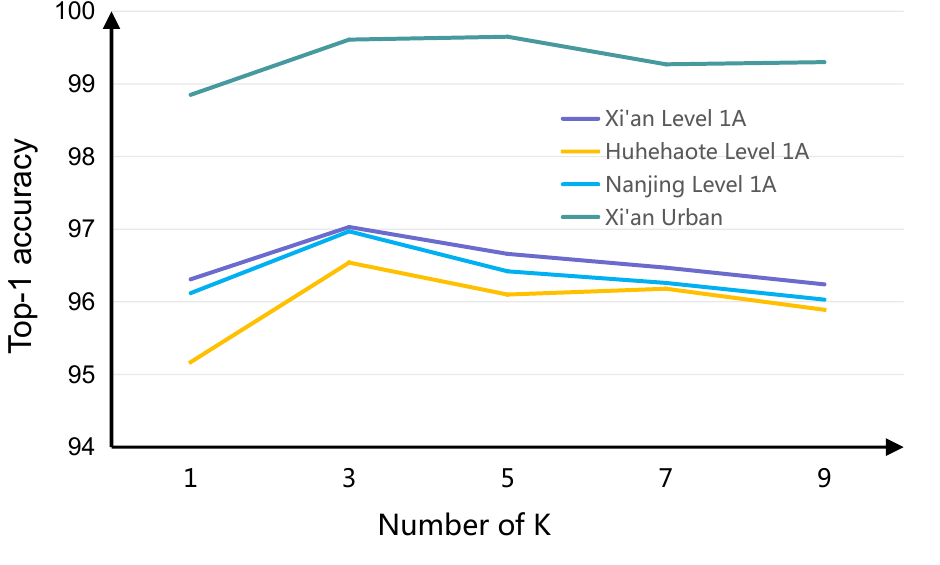
Figure 7. Results of our GCA-module with various numbers of k using SCCA-net as backbone